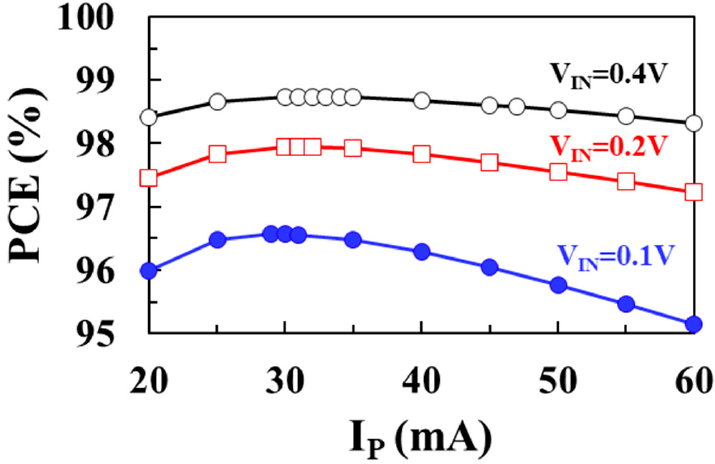
Figure 11. Modeled PCE according to peak inductor current for different input voltages.